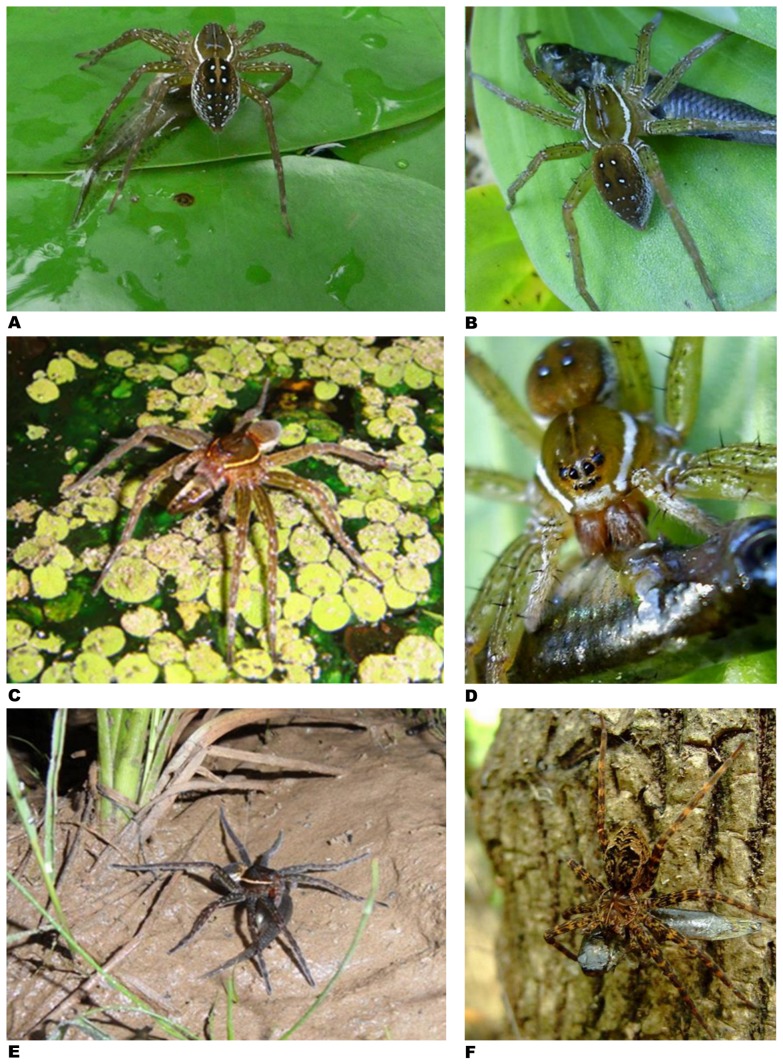
Fish caught by spiders – examples from North America.
A –
Dolomedes triton caught mosquitofish (Gambusia) in backyard pond near Tampa, Florida (photo by Stacy Cyrus, DavesGarden website; report # 24). B –
Dolomedes triton feeding on fish (probably mosquitofish Gambusia holbrooki) in garden pond near Lady Lake, Florida (photo by Machele White, Lady Lake, Florida; report # 20). C –
Dolomedes triton feeding on small fish (presumably least killifish Heterandria formosa) on Tsala Apopka Lake, Florida (photo by Claire Sunquist-Blunden, Ocala, Florida; report # 19). D –
Dolomedes triton feeding on fish (probably mosquitofish Gambusia holbrooki) in garden pond near Lady Lake, Florida (same incidence as in Fig. 2B; report # 20). E –
Dolomedes triton devouring fish (probably mosquitofish Gambusia holbrooki) on edge of small, slow-moving stream near Fayetteville, North Carolina (photo by Patrick Randall, Fort Bragg, North Carolina, USA; report # 30). F –
Dolomedes okefinokensis feeding on small fish (probably mosquitofish Gambusia holbrooki) in swamp in Big Cypress National Preserve, Florida (photo by Misti Little, Stagecoach, Texas; report # 28).